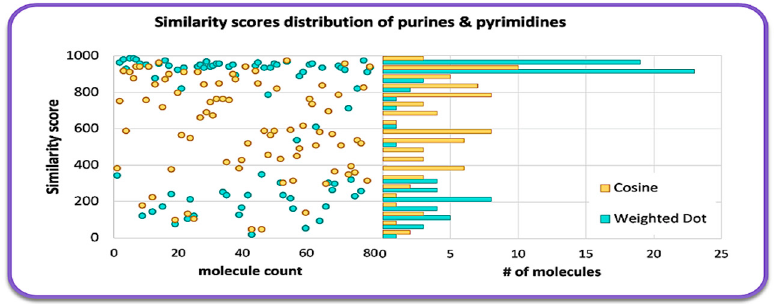
Figure 2. Histogram of MS similarity of QCEIMS predicted versus experimental mass spectra for 80 purines and pyrimidines, comparing weighted dot product and cosine similarity